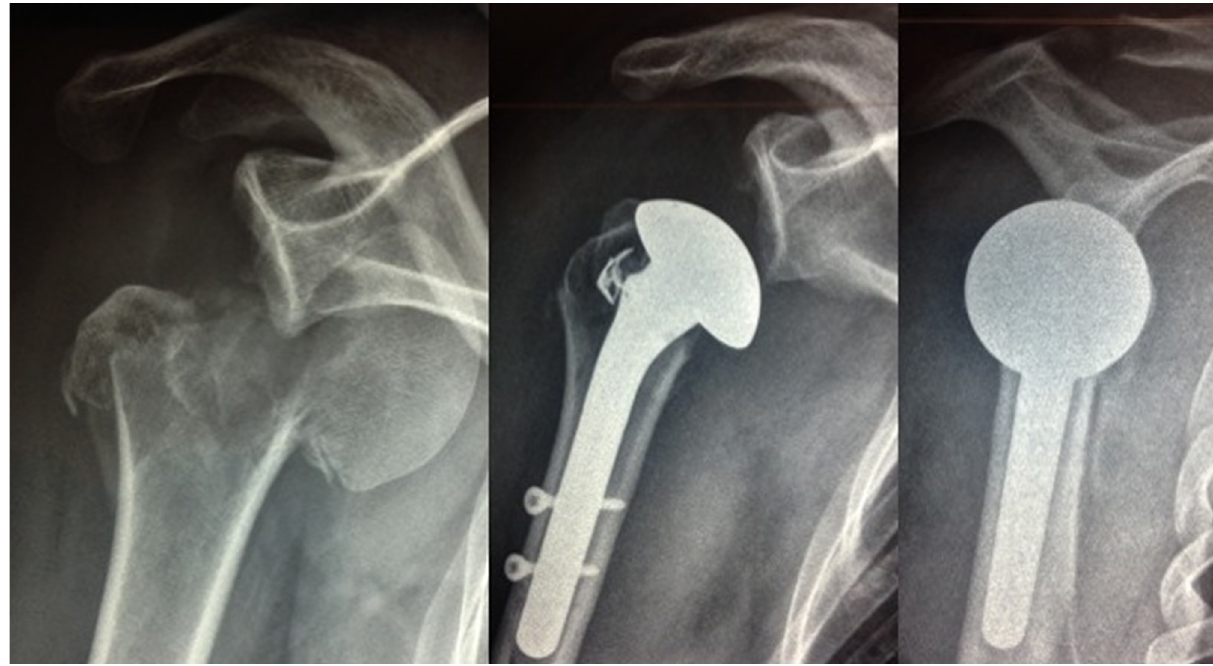
Figure 5. Four part dislocated fracture in a 55-year-old patient (right shoulder) and postoperative